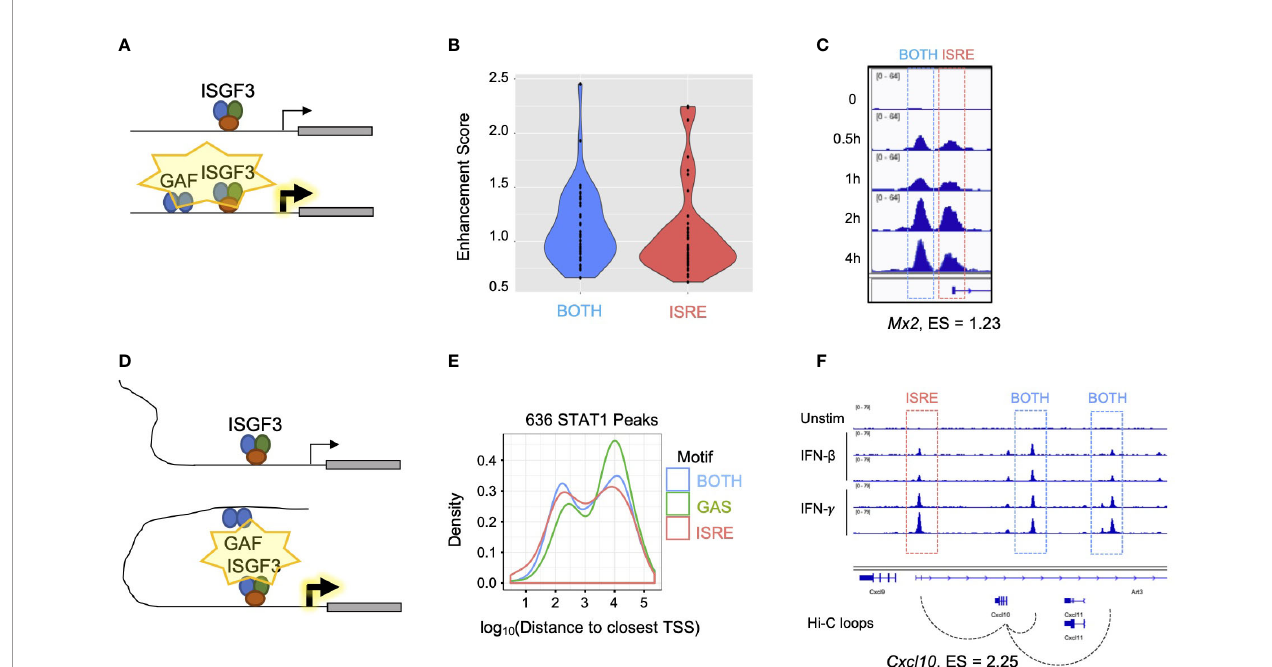
FIGURE 7 | Gene-speci fi c mechanisms of GAF enhancement. (A) Schematic of GAF and ISGF3 colocalized at promoters to enhance ISG expression. (B) Violin plots of Enhancement scores for genes with STAT1 promoter peaks containing BOTH motifs (GAS+ISRE) vs. ISRE motif alone. (C) STAT1 ChIP-seq tracks at Mx2 promoter which has a BOTH peak in the proximal promoter as well as an ISRE peak at the TSS. (D) Schematic of distal GAF binding looping to promoters of ISGs to enhance ISG expression. (E) Density plot of distance from all STAT1 peaks to nearest TSS, separated by peak motif category. (F) Genome browser tracks of STAT1 ChIP-seq data and Hi-C data (46) at Cxcl10 locus demonstrating contact of two BOTH peaks with the